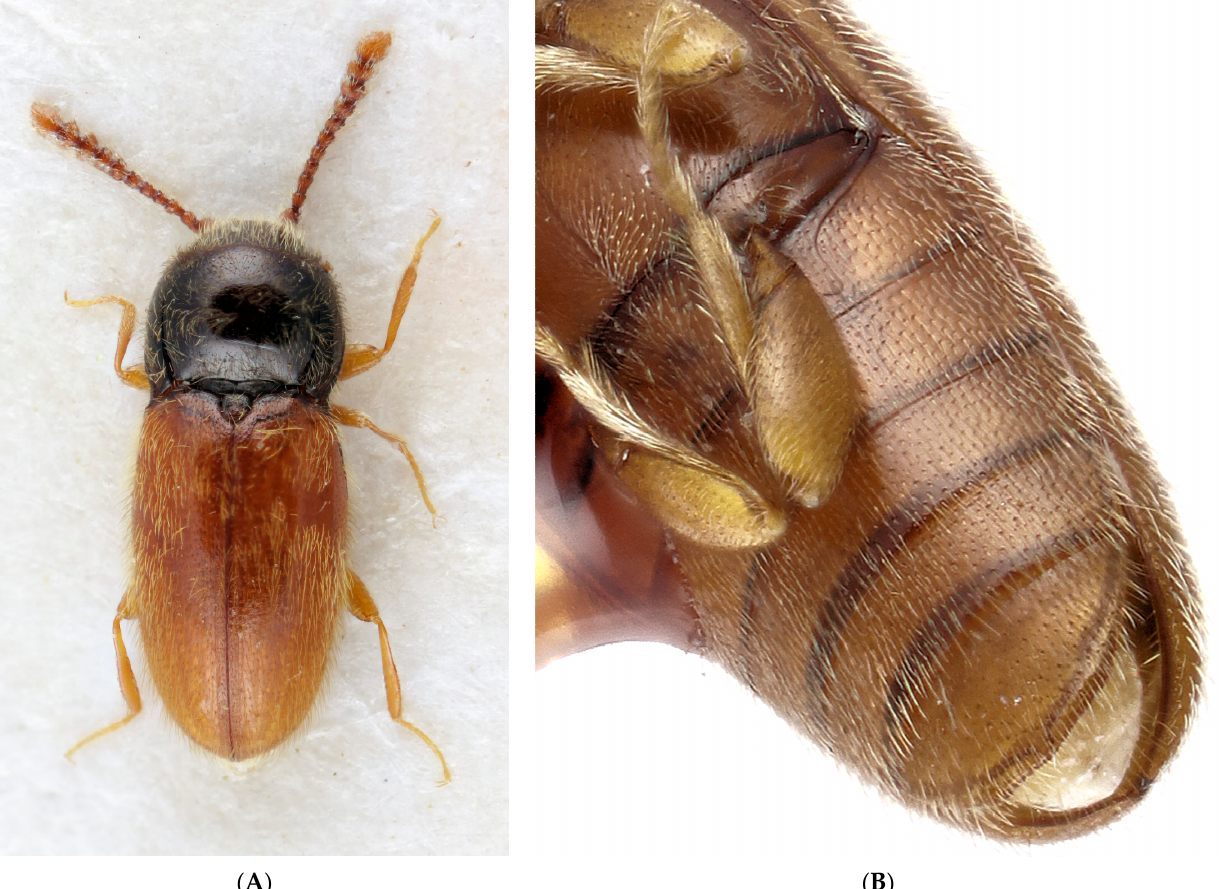
Figure 4. ( A ) Anischia bicolor Lawrence, dorsal view, length 2.20 mm; ( B ) Anischia kuscheli Lawrence, paratype, ventral view of abdomen showing metacoxa and metacoxal line on right side on first visible ventrite. Note the missing metacoxal plates and free apical abdominal segments; length from left upper corner to end of elytra is 1.03